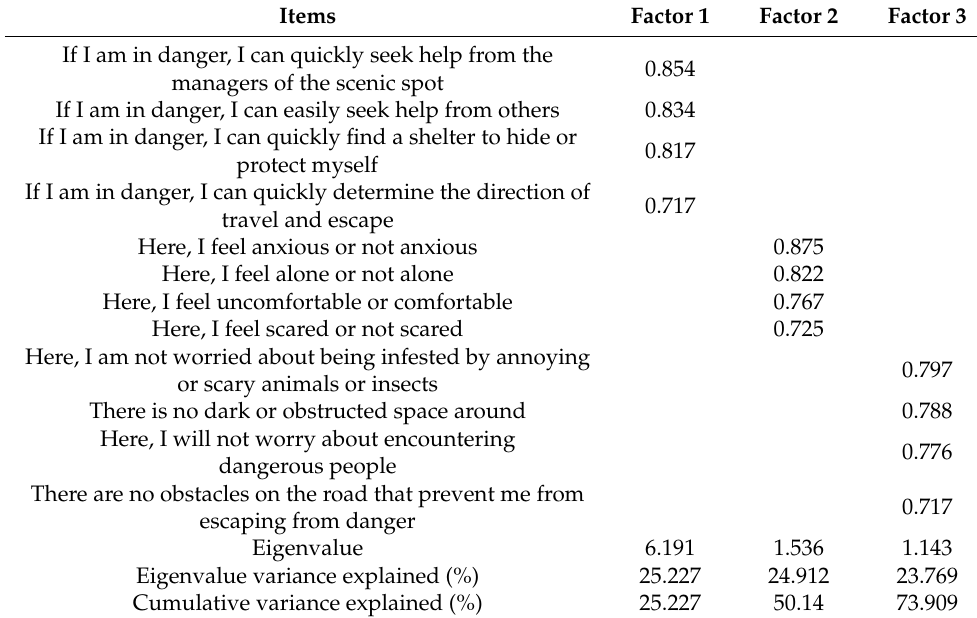
Table 2. Results of exploratory analysis.